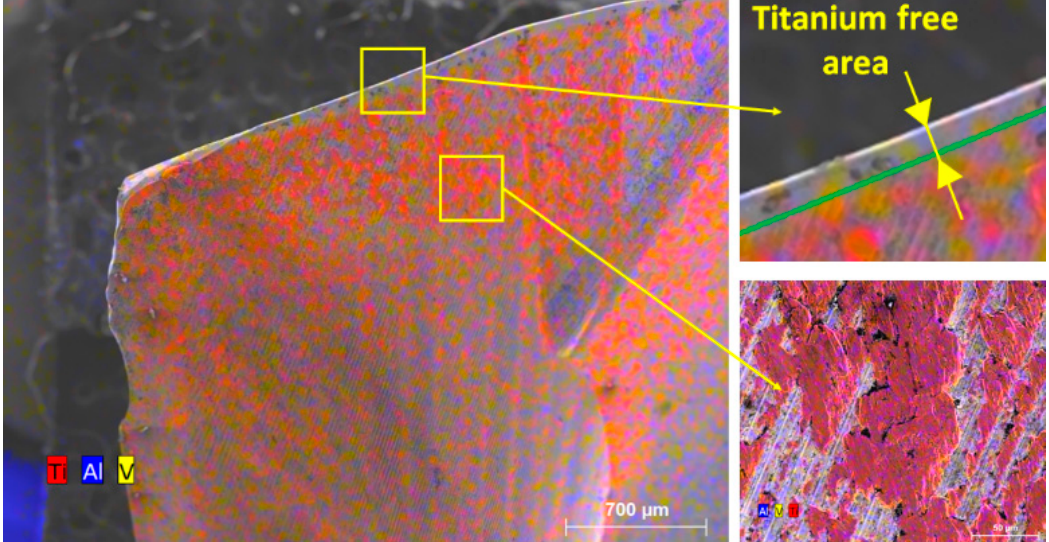
Figure 15. After 25 holes in the stack and passing through the CFRP, the cutting edge is cleaned from adhered titanium and some adhesion zones are still present on the cutting face. There is no evidence of predominance of α or β phases.